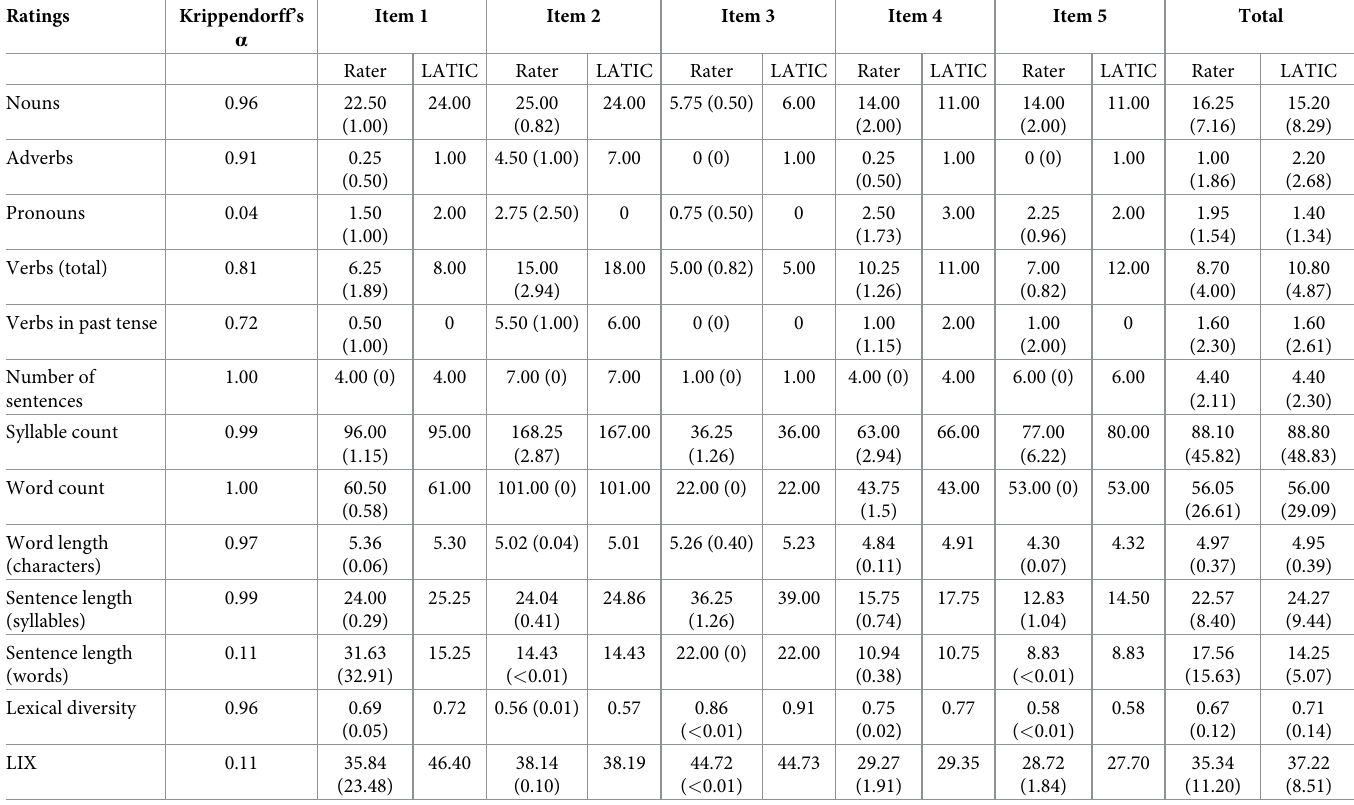
Table 2. Comparison of coders’ ratings and LATIC’s results including